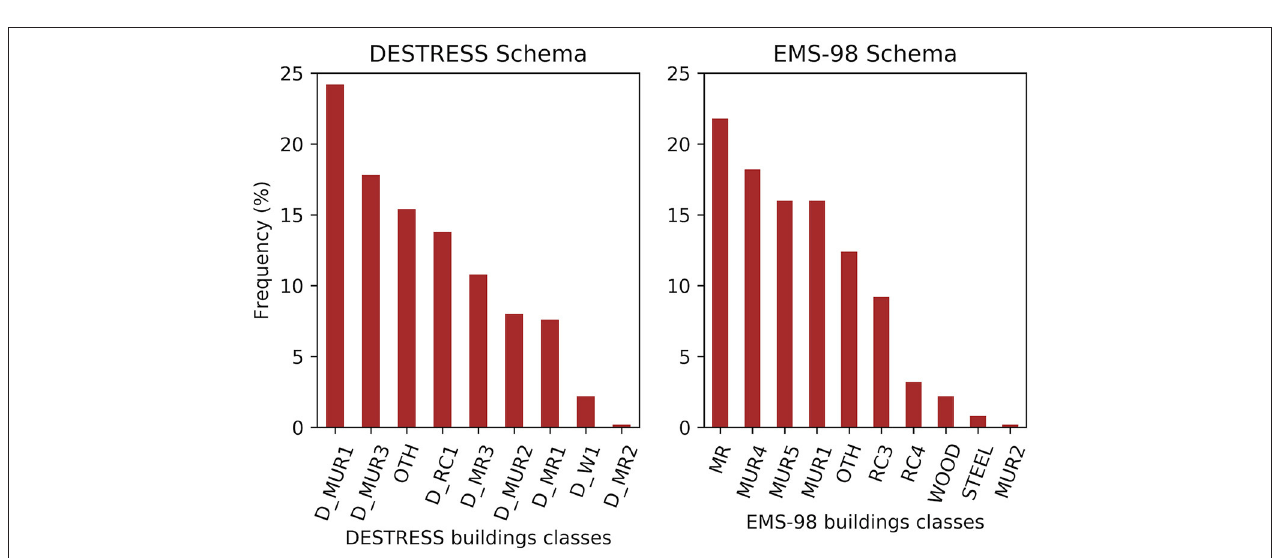
Frontiers in Built Environment |